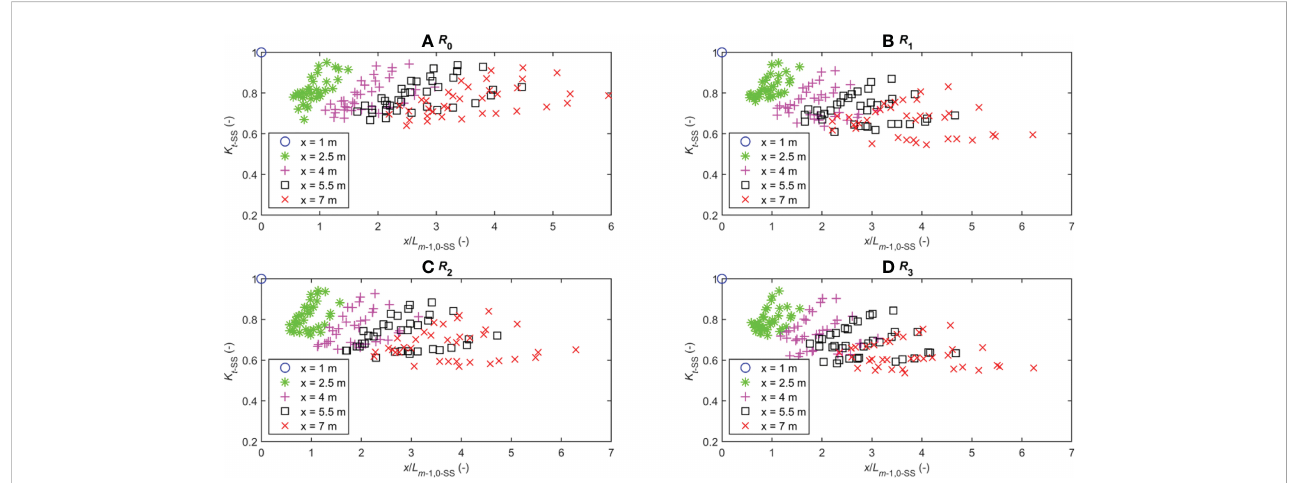
FIGURE 7 Variation in the wave transmission coef fi cient K t-SS along the reef: (A) Smooth reef; (B) Crushed stone reef 1; (C) Crushed stone reef 2; (D) Simulated coral